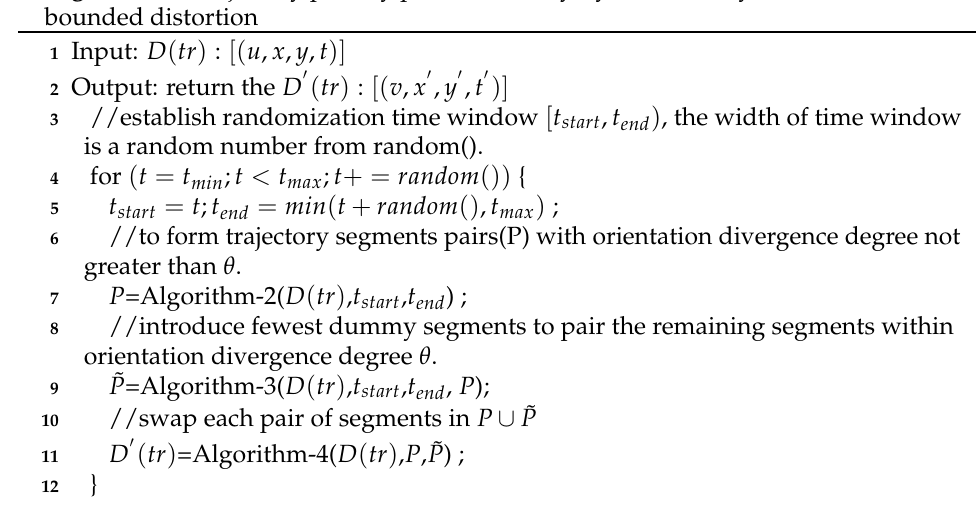
Algorithm 1: Trajectory privacy preservation by dynamic anonymization with bounded